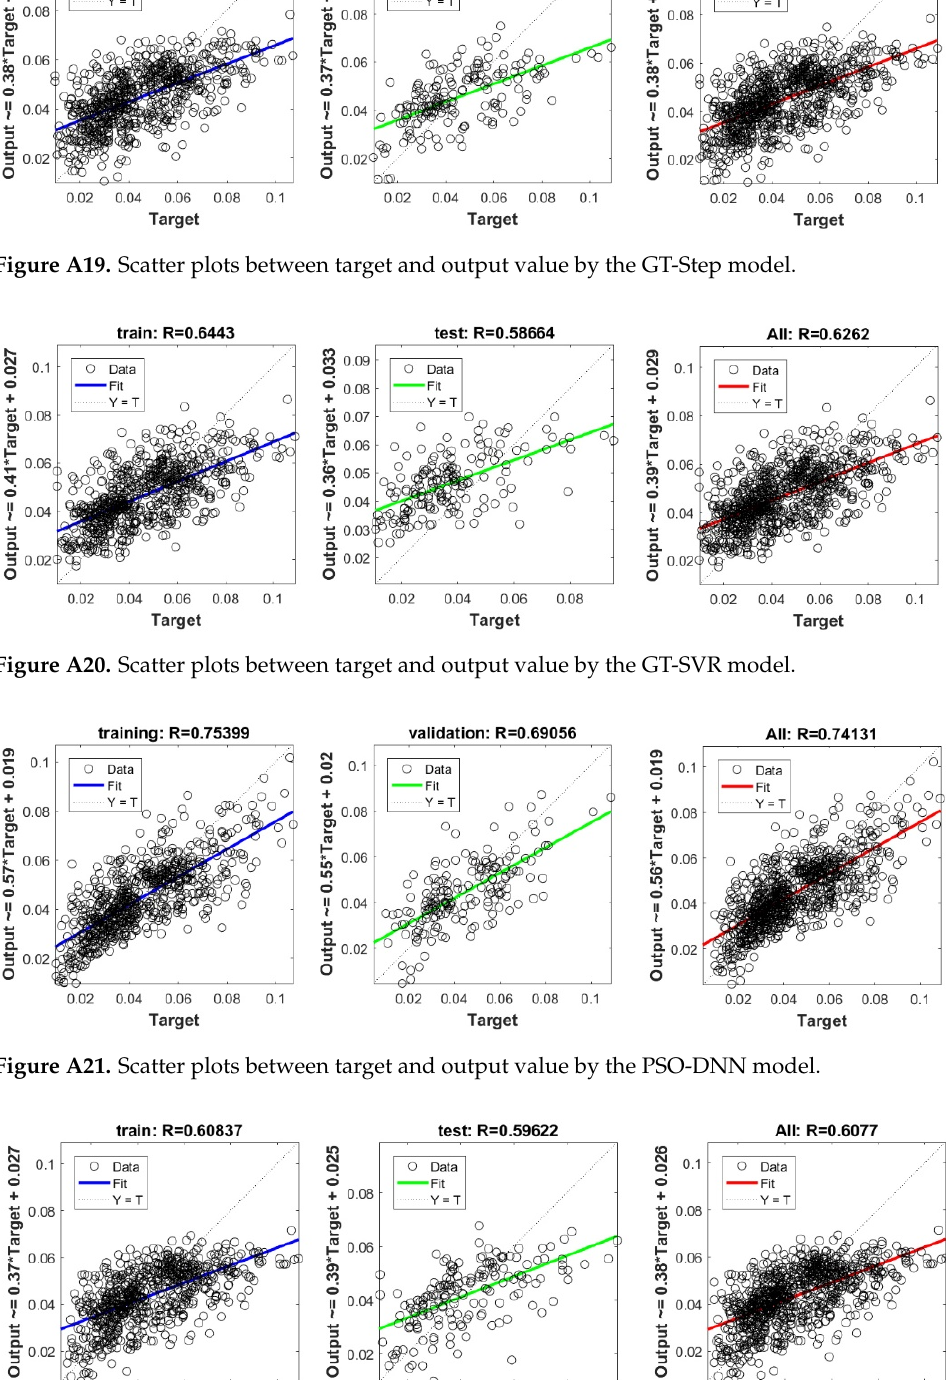
Figure A22. Scatter plots between target and output value by the PSO-ELM model.